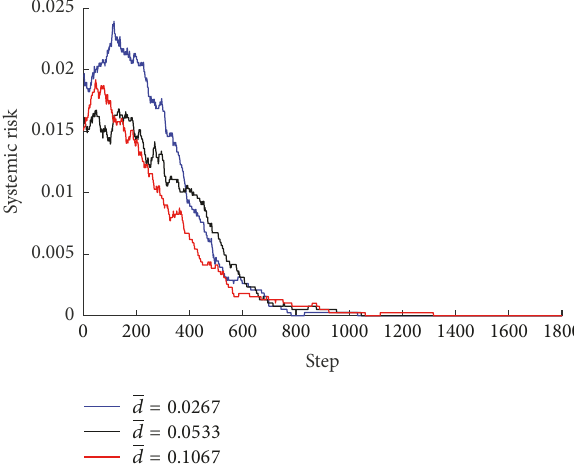
Figure 7: Systemic risk under different values of 𝑑 . The parameters are set as 𝜃 = 0.02 , 𝛿 𝑎 V 𝑒 = 0.009 , 𝜃 = 0.02 , 𝐶 = 0.03 , 𝜎 𝐴 = 0.15 , 𝜎 = 0.25 , 𝐴 = 1000 , 𝑤 = 500 , 𝜒 = 0.3 , 𝛽 = 0.25 , 𝐵𝑎𝑛𝑘𝑁𝑜 = 200 , 𝑤 𝐴𝑠𝑠𝑒𝑡𝑁𝑜 = 150 , and 𝑟 = 0.008 𝑏